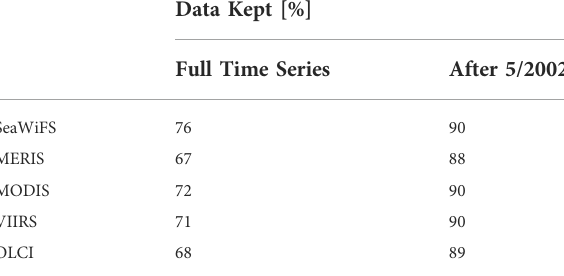
TABLE4ThefractionofdatakeptafterapplyingtheTGDMforthetwo periods, separately shown for each